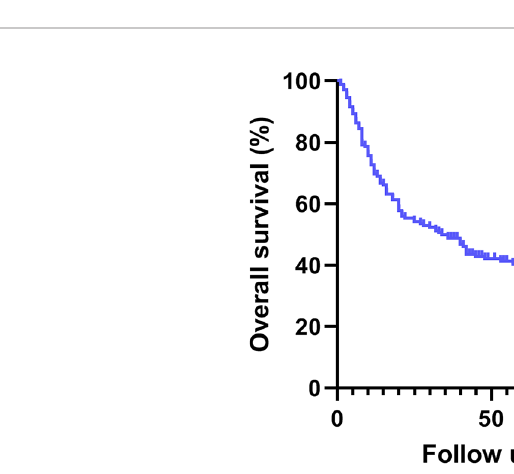
FIGURE 1 | Overall survival curve of 168 patients with gallbladder cancer treated by radical